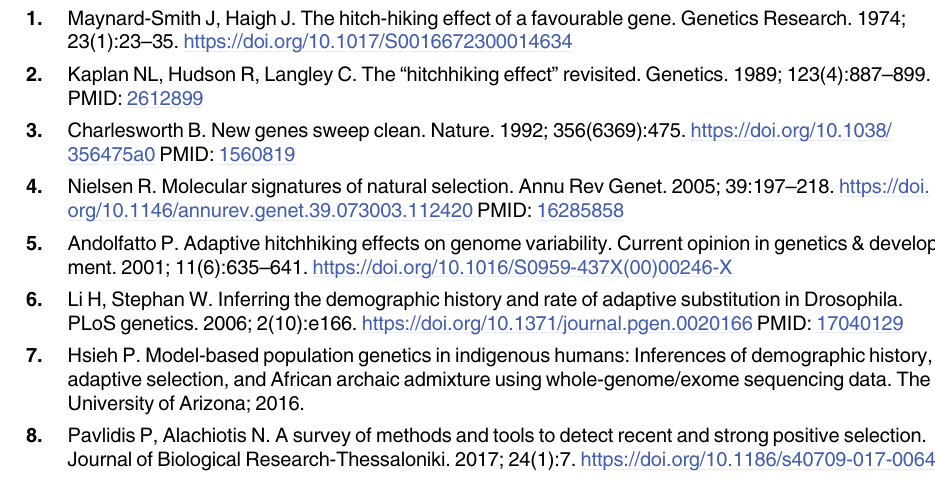
S2 Table. Selective sweep detection rate. The proportion of all samples detected as selected sweeps by all our detection methods. Here “2p” indicates a demographically correct neutral control, while “1p” indicate control with panmictic neutral samples. “200k” indicates only the first 200kb of data is used for analysis, and “600k” indicates that the entire region is used. S3 Table. Selective sweep detection rate, comparison between different sample sizes. Com- parison of detection rates by summary statistics and evolBoosting, on population data simu- lated by R ( n = 50) and SLiM ( n =